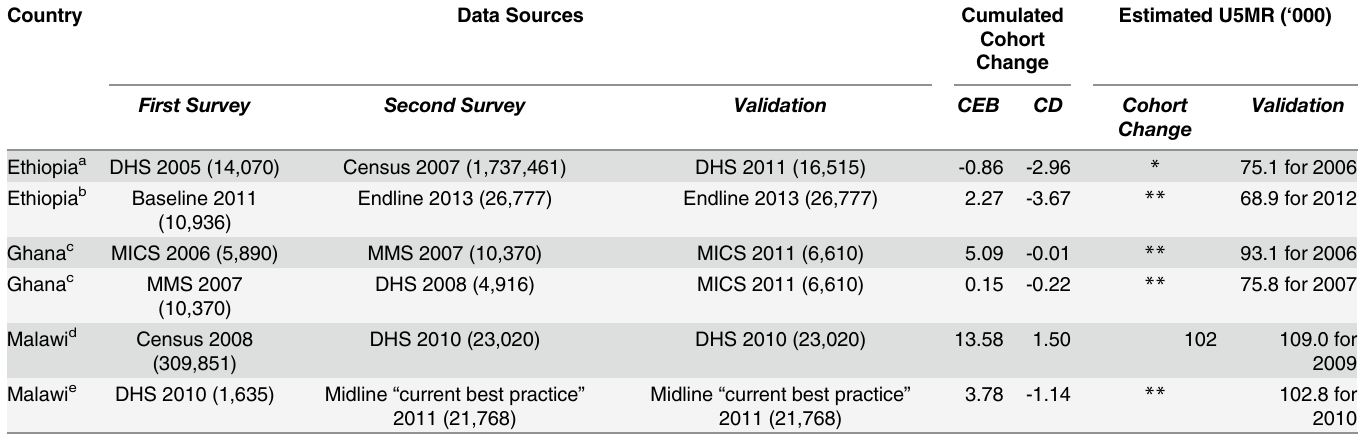
Table 5. Results of Cohort Change